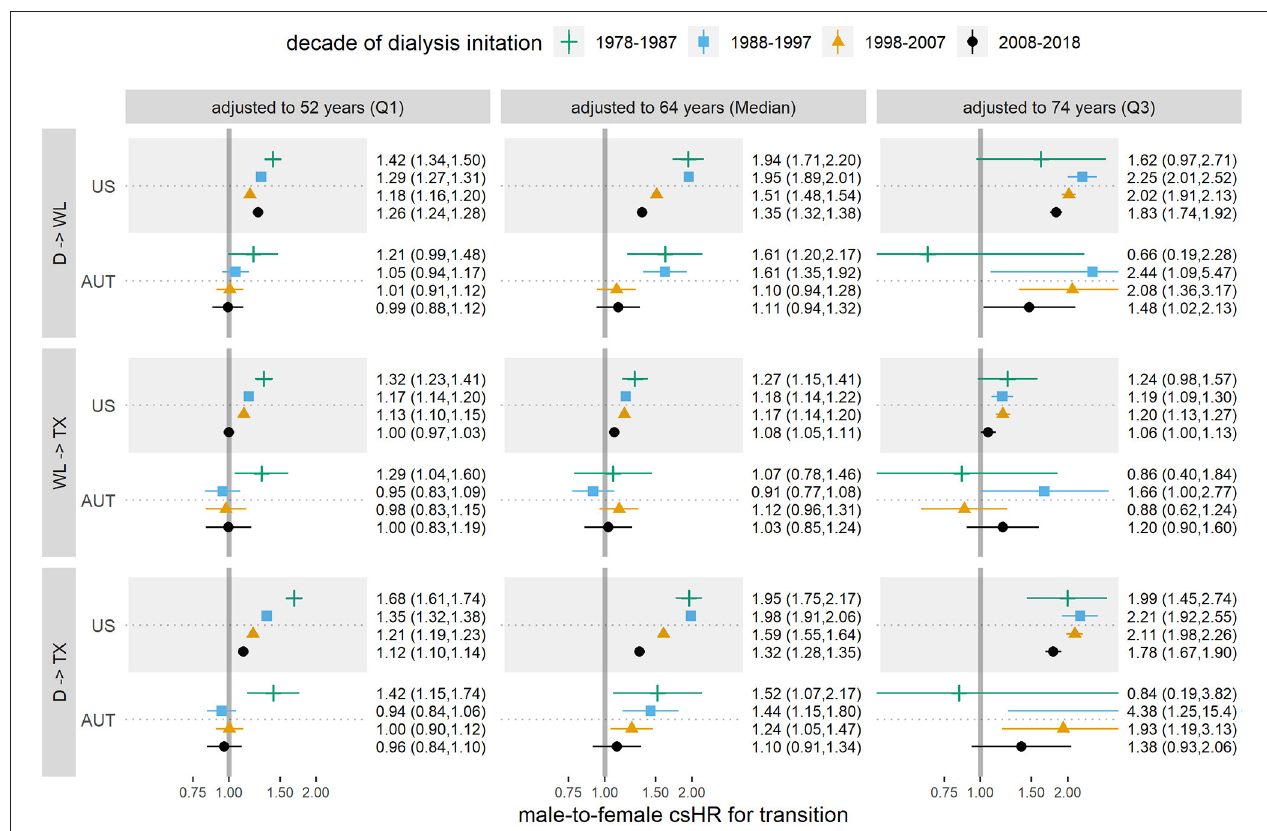
FIGURE 2 | Male-to-female cause specific hazard ratios (csHRs) with 95% confidence intervals for each state transition and decade, adjusted to median age (64 years) and 25% (52 years) and 75% (74 years) age quantiles, in Austria (AUT) and the USA. (D) dialysis initiation, (WL) first entry in wait-list, (TX) first kidney transplantation. The considered transitions are dialysis to wait-list (1st row), wait-list to TX (2nd row), dialysis to TX with wait-list as intermediate state (3rd row). Age is incorporated via restricted cubic splines. Results are based on data from the ADTR/Eurotransplant (AUT) ( 26, 29) and USRDS (US)